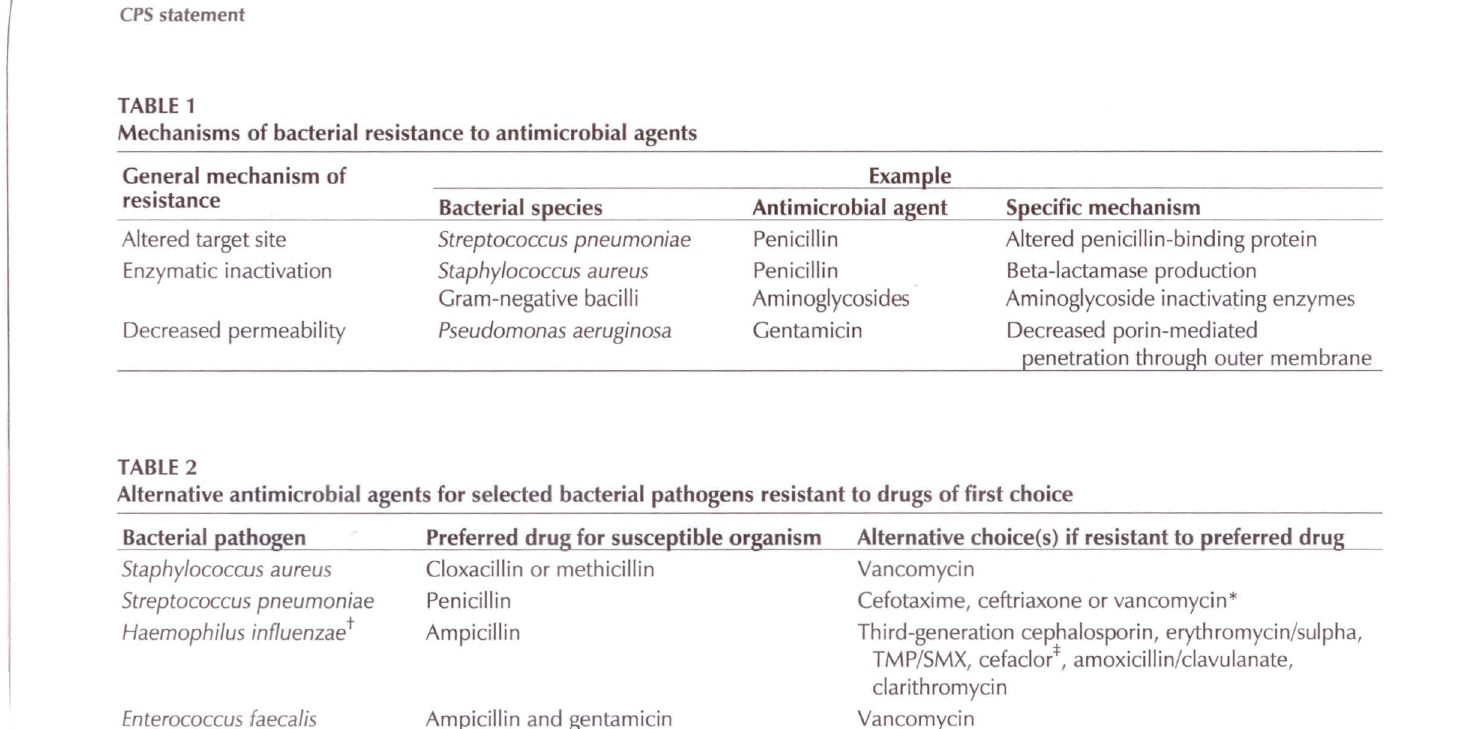
Mechanisms of bacterial resistance to antimicrobial agents General mechanism of